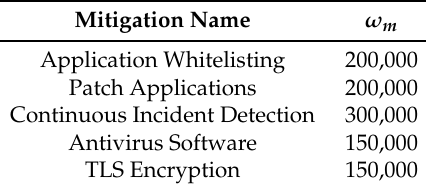
Figure 7. Gaussian KDE estimates of losses under different ways of spending the budget, from 100,000 simulations of L ( T ) . The ways of spending are: no spending on mitigation, equal spending on each mitigation, spending chosen to minimise average losses and spending chosen to minimised VaR of the losses at the α = 0.01 level. Table 4. Names and maximum costs (per year) of different methods of mitigating cyber attack. These methods are taken from the Australian Signals Directorate The Australian Signals Directorate (2017). We follow the ordering of expenses given in this source, but the exact values are chosen for the sake of demonstrating the use of the